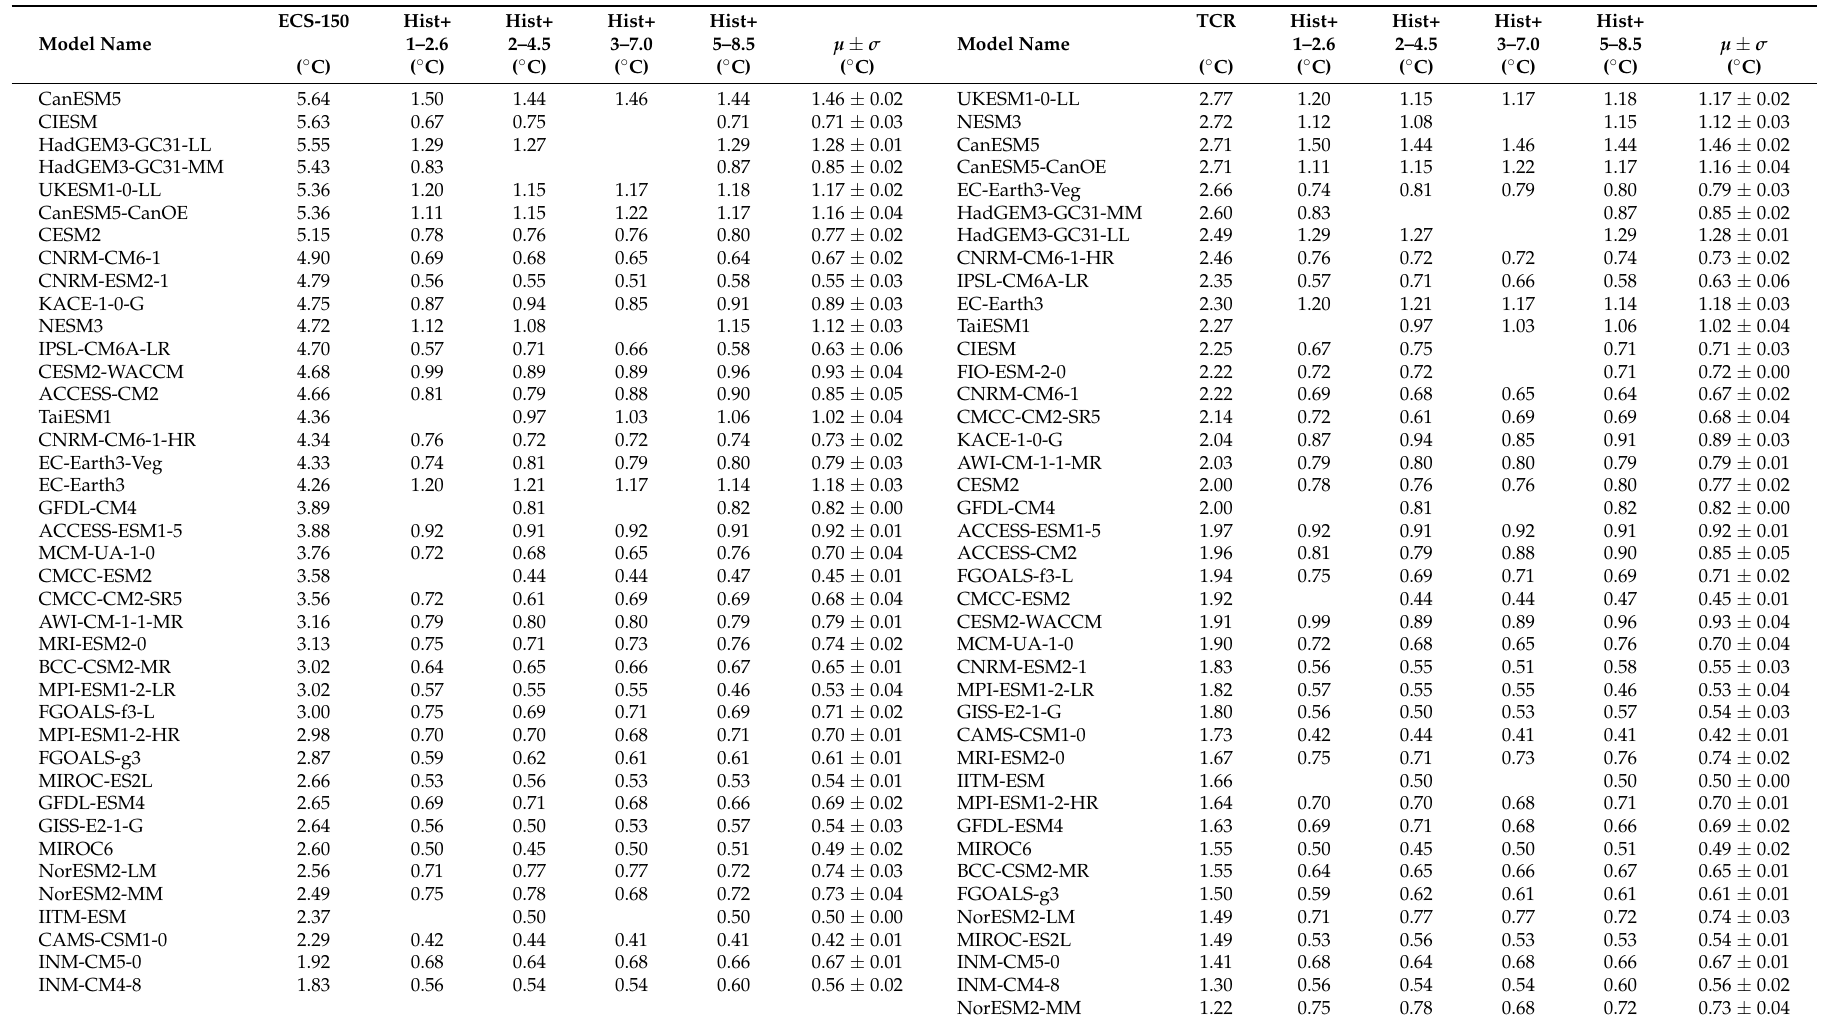
Table A2. Temperature change from 1980–1990 to 2011–2021 for the CMIP6 Global Circulation Models (GCMs). Ranking using ECS-150 and TCR from Hausfather et al. [5]. See Figure